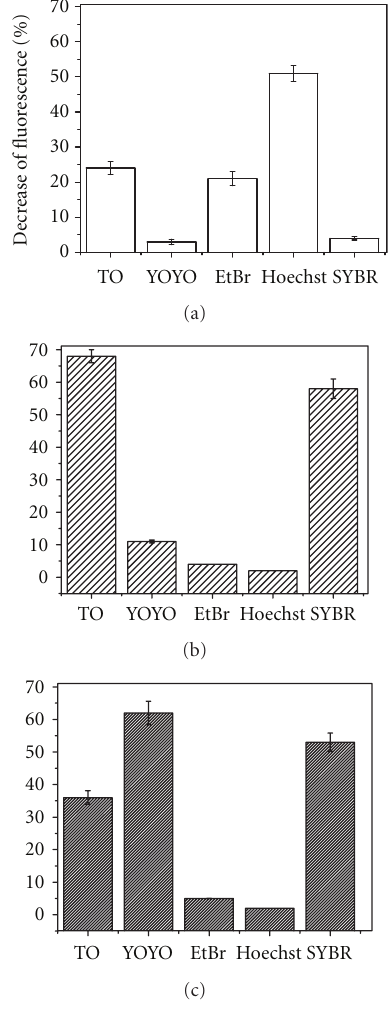
Figure 4: Comparison of fluorescence signaling by various chro- mophores on the (a) ATP-, (b) theophylline- and (c) thrombin- binding aptamers. The % decrease of fluorescence (%) is calculated from the di ff erence in fluorescence intensities of the chromophores (25nM) in presence of 10nM aptamer with and without 10nM target. Data presented in plot is the mean of three measurements and error bars indicate standard